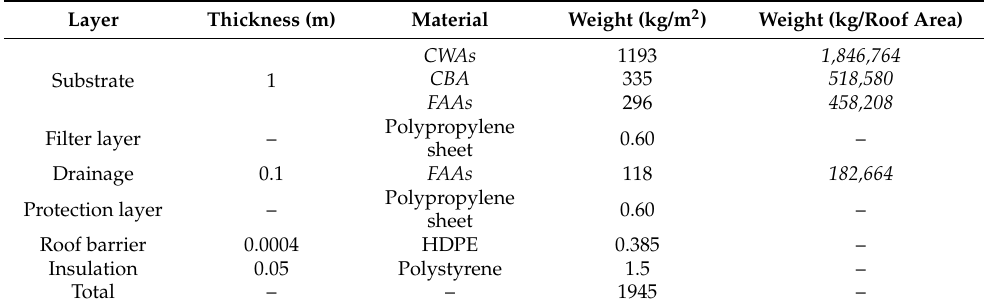
Table 4. Materials required for the waste-based green